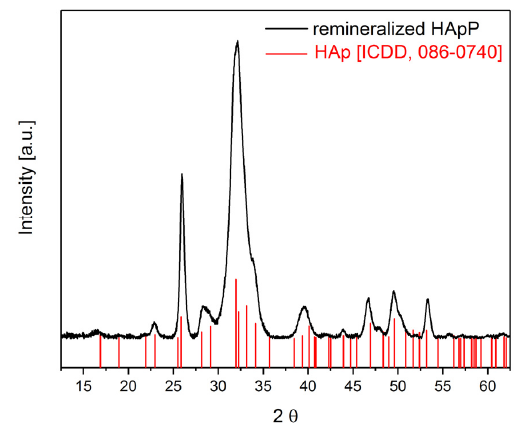
Figure 4. PXRD pattern of a crystallized HApP after incubation in the remineralization solution for seven days (pH 7.4).